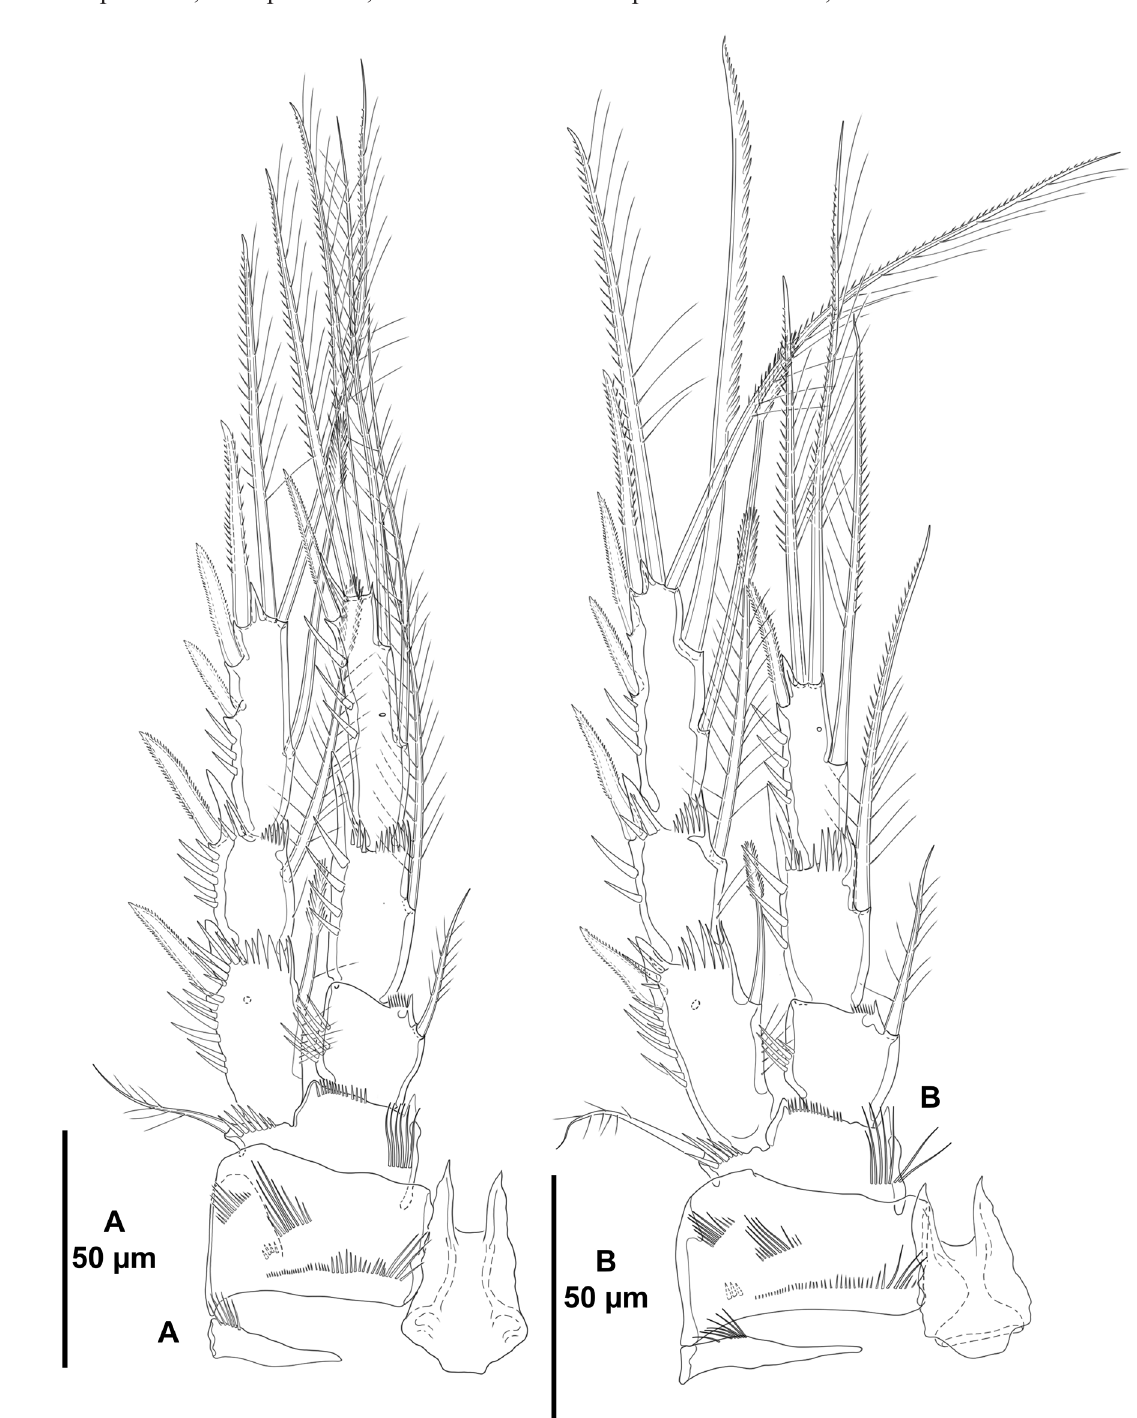
Fig. 7. Typhlamphiascus medici sp. nov., paratype, ♀ (ICML-EMUCOP-180119-41). A . P3, anterior view. B . P4, anterior